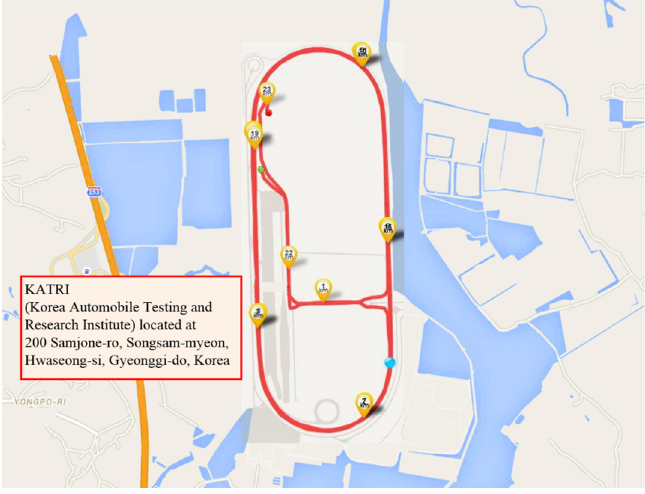
Figure 6. Test track for HVAC system test.